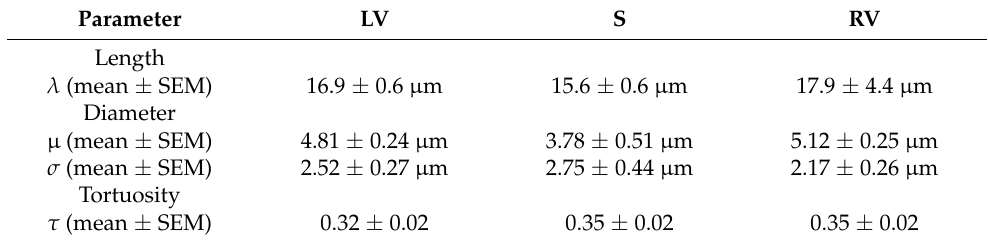
Figure 3. Architectural parameters. Data obtained from the left ventricle (blue), septum (red), and right ventricle (green) of six hearts. ( a ). Relative frequency distribution of segment length. Data were fitted by one-phase exponential decay. ( b ). Relative frequency distribution of segment diameter. Data were fitted by Gaussian equation. ( c ). Relative frequency distribution of segment tortuosity. Data were fitted by one-phase exponential decay. Curves between LV, S, and RV were compared by F tests. Table 4. Architectural parameters. Values were obtained by non-linear regression of frequency distribution of data from left ventricle (LV), septum (S), and right ventricle (RV) of six mouse hearts (see Figure 3). λ : length constant of one-phase exponential decay. µ and σ : mean and standard deviation of Gaussian distribution. τ : tortuosity constant of one-phase exponential